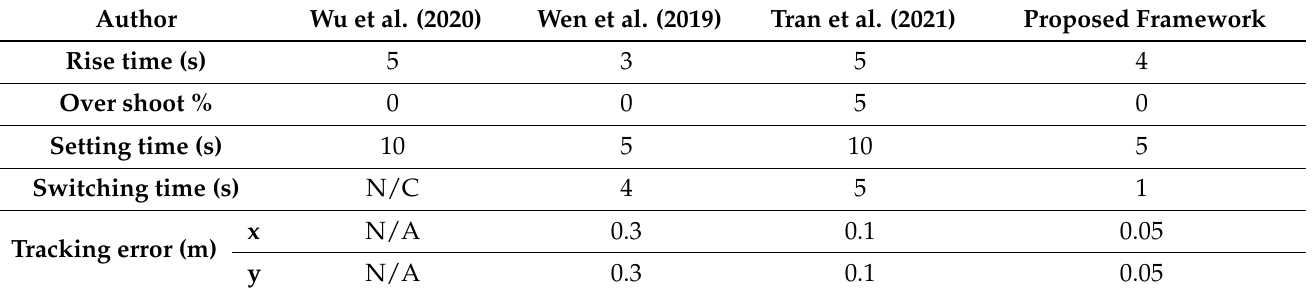
Table 3. Formation control performance